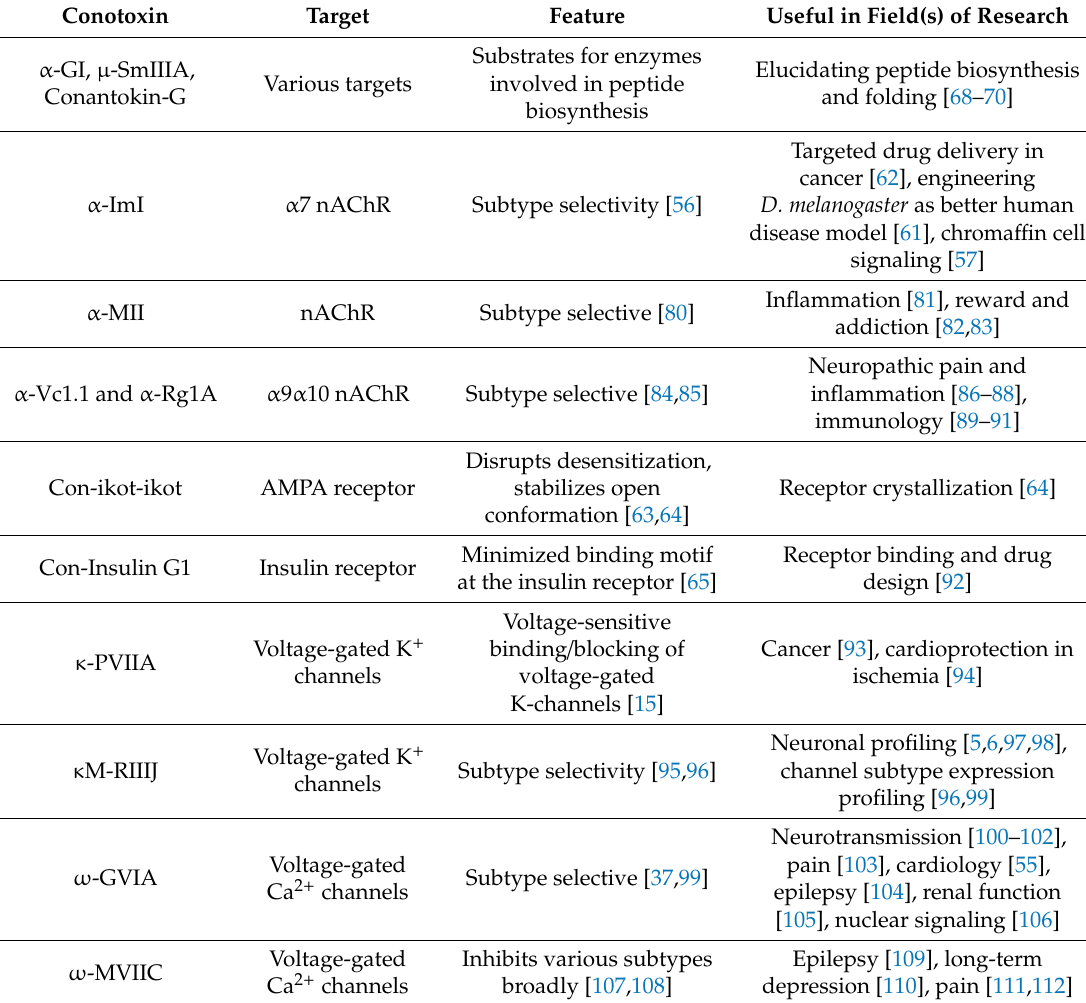
Table 3. Examples of conotoxins used as research